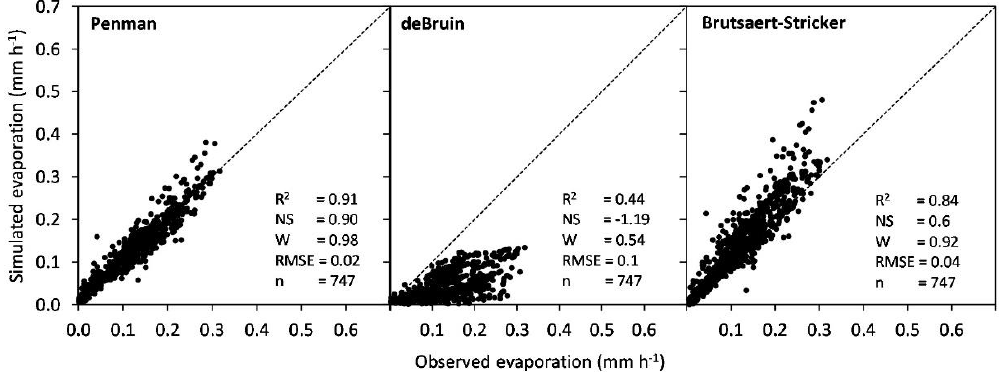
Figure 9. Combination models including the wind function to maximize R 2 (RMSE in mm h −1 ). Water 2020 , 12 , x FOR PEER REVIEW